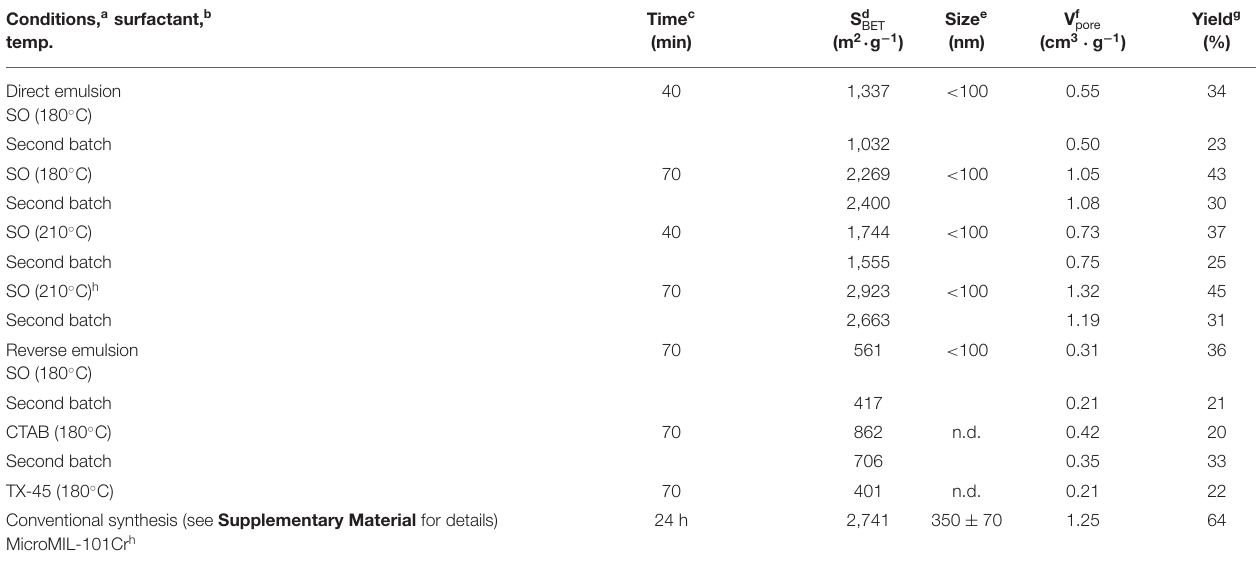
TABLE 1 | Reaction conditions and results for the synthesis of nanoMIL-101Cr. Conditions, a surfactant, b